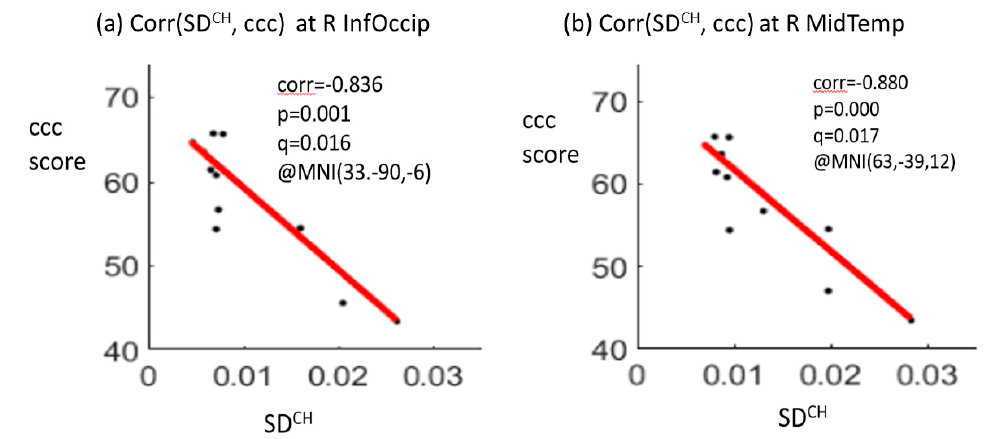
Figure 3. Significant negative correlations between the crystallized composite score (ccc) and the SD BOLD (blood-oxygen-level-dependent signal variability in standard deviation) at the right inferior occipital gyrus (R InfOccip) ( a ) and right middle temporal gyrus (R MidTemp) ( b ) for the chemotherapy (CH) group at time point 1. Note: ccc, crystallized composite score; corr, correlation coefficient; p -value, t-test p -value; q-value, FDR-corrected p -value after multiple comparison; MNI (x, y, z), Montreal Neurological Institute coordinates (x, y, z); SD CH , SD BOLD for the CH group.